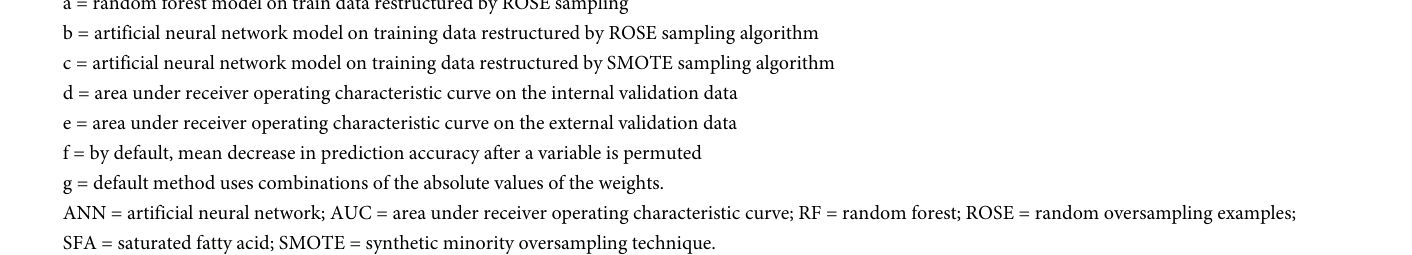
Internal (n = 4877) and external (n = 6673) validation data acquired AUROC estimates of 73.7% and 74.0%, respectively, for the ADA diabetes risk test. When ROC curves were com- pared using the DeLong test, the AUROC estimates from the four best-performing models did not differ significantly from the corresponding ADA diabetes risk test estimates ( p > 0.05), with AUROC differences ranging from 0.2–2.8% and 0.0–2.5% on internal and external valida- tion data, respectively. Performance of the ADA diabetes risk test using NHANES data,